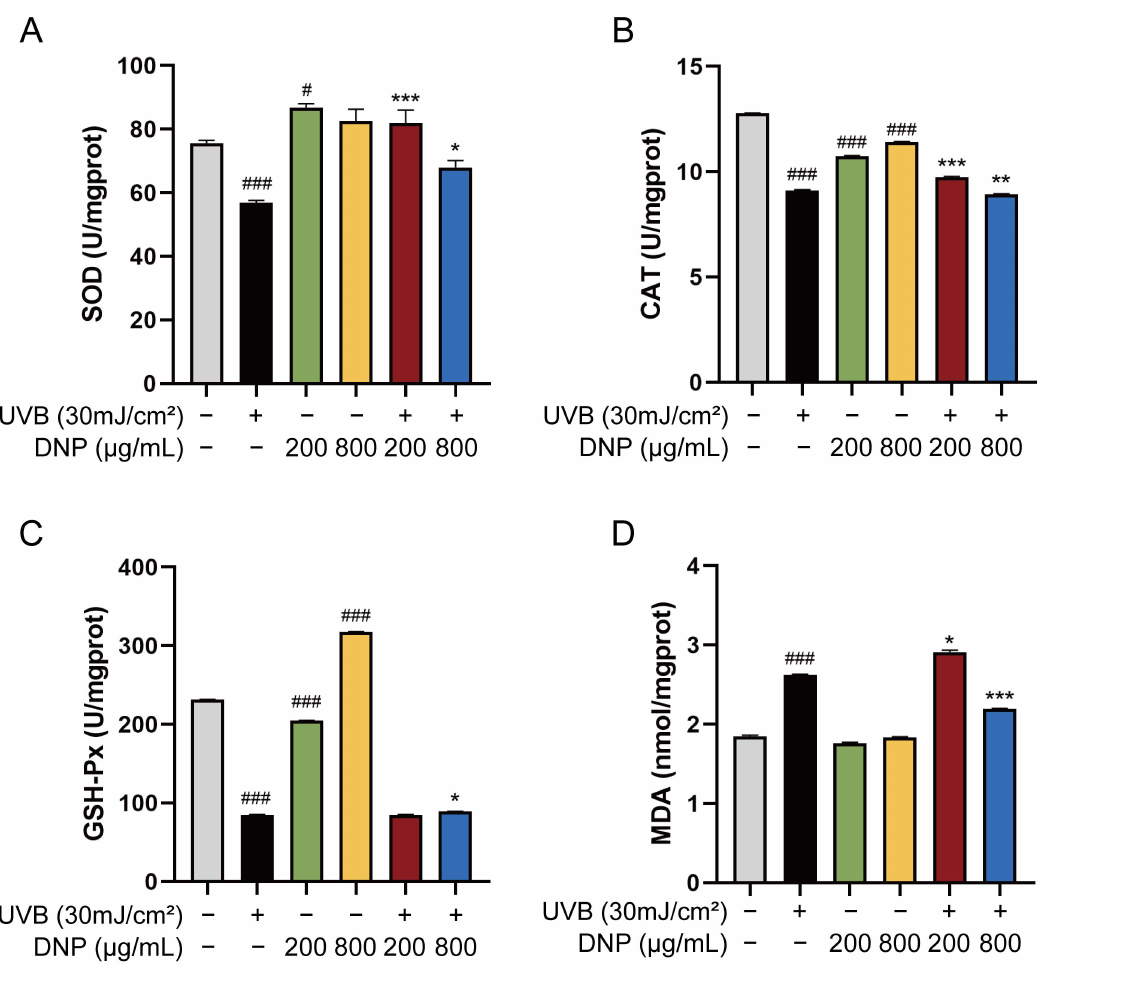
Figure 3. DNPs alleviate UVB-induced oxidative damage in HaCaT cells. Activities of ( A ) SOD, ( B ) CAT, and ( C ) GSH-Px. ( D ) Malondialdehyde (MDA) levels. # p < 0.05, and ### p < 0.001 vs. control group; * p < 0.05, ** p < 0.01 and *** p < 0.001 vs. UVB